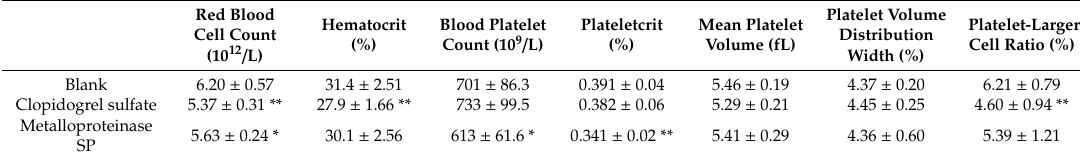
Table 2. Hemodynamic examination of venous blood in clopidogrel and metalloproteinase SP treated